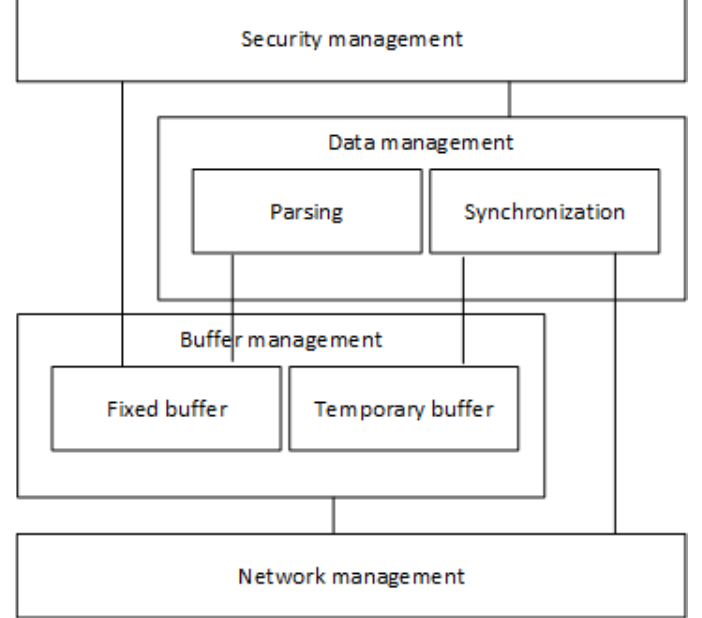
Figure 3. Securebox architecture.